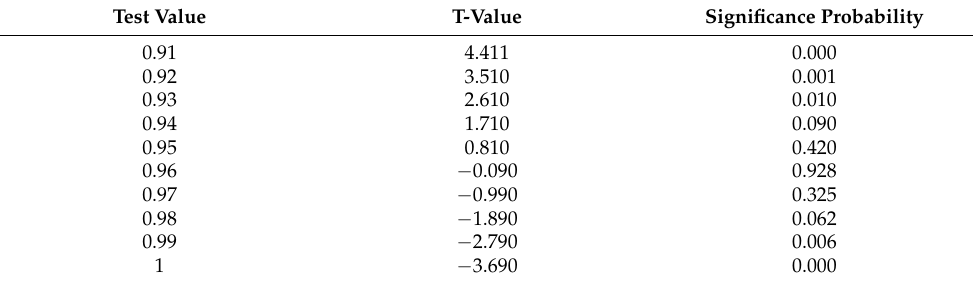
Table 4. Significance probability according to test value of training